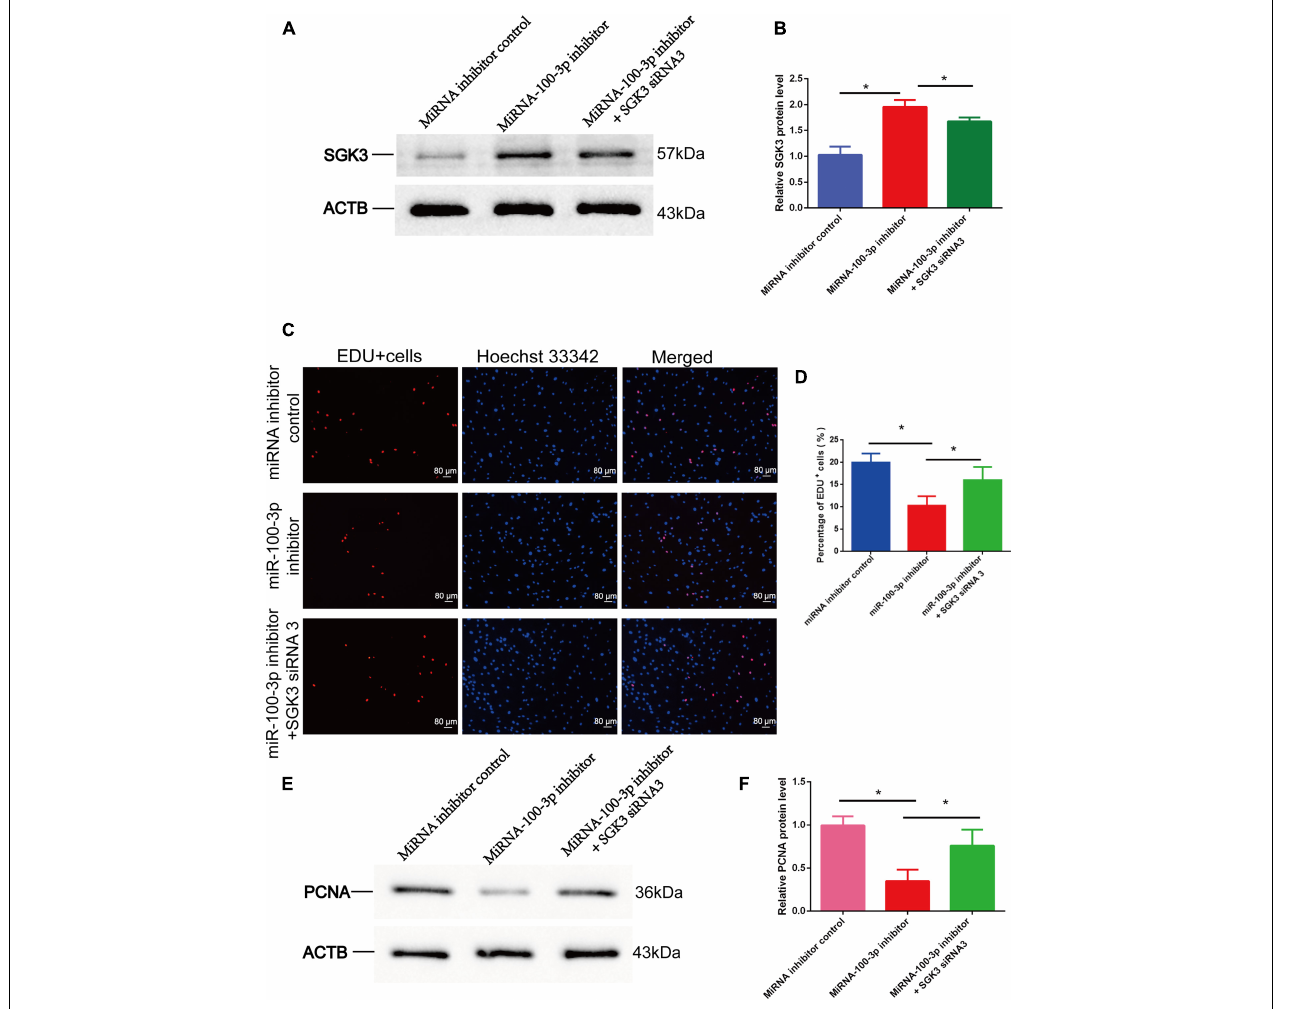
FIGURE 8 | The effect of miR-100-3p and serum/glucocorticoid regulated kinase family member 3 (SGK3) siRNA 3 on the DNA synthesis and proliferation of human Sertoli cells. (A,B,E,F) Western blots displayed the expression levels of SGK3 (A,B) and proliferating cell nuclear antigen (PCNA) (E,F) proteins in human Sertoli cells affected by miRNA inhibitor control, miR-100-3p inhibitor, as well as miR-100-3p inhibitor and SGK3 siRNA 3. (C,D) The 5-ethynyl-2 (cid:48) -deoxyuridine (EdU) incorporation assay revealed the percentages of EdU-positive cells in human Sertoli cells affected by miRNA inhibitor control, miR-100-3p inhibitor, as well as miR-100-3p inhibitor and SGK3 siRNA 3. Scale bar in panel (C) = 80 µ m. * denoted the statistical differences between miR-100-3p inhibitor and SGK3 siRNA 3 and miR-100-3p inhibitor or between miR-100-3p inhibitor and miRNA inhibitor